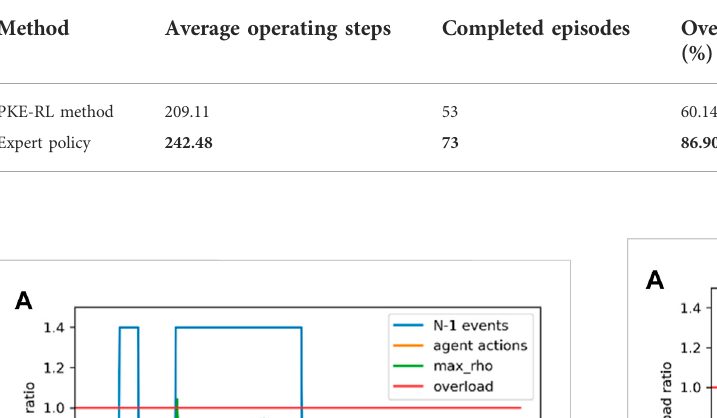
TABLE 2 performance comparison between the pke-rl method and expert policy.